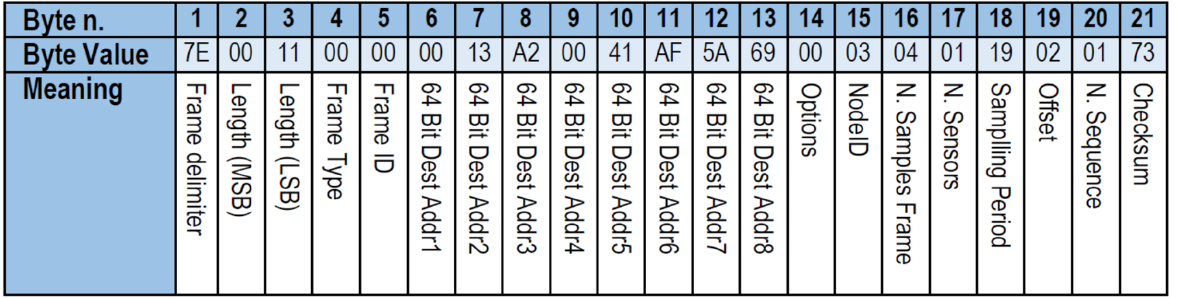
Figure 5. Configuration frame sent by the Coordinator Node to one Smart Measuring Node.